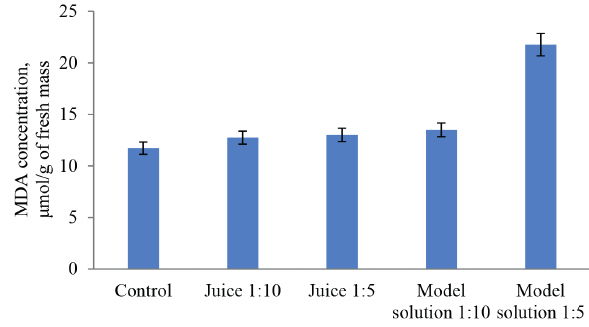
Figure 6 MDA concentration in onion roots treated with apple juice and model solutions